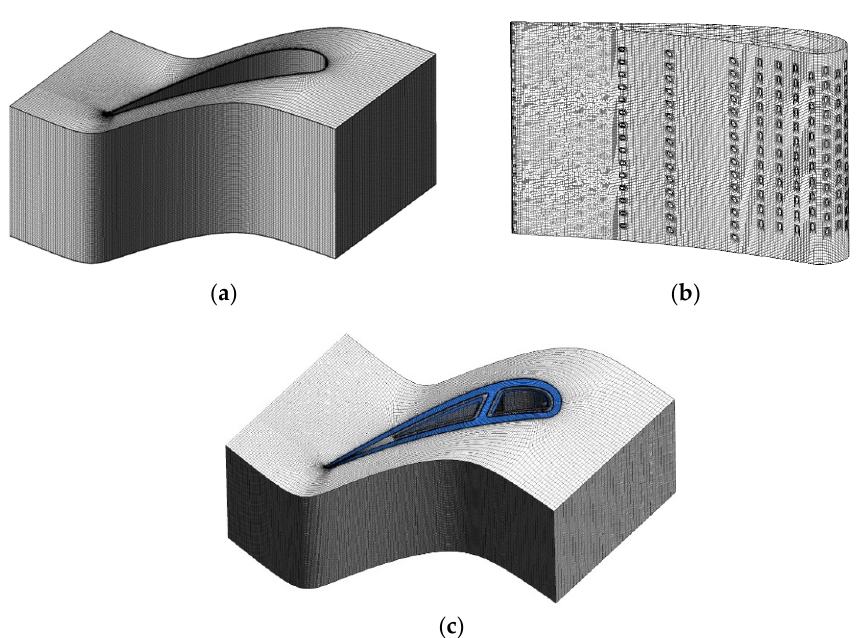
Figure 6. Mesh for data ‐ driven heat transfer analysis and validation: ( a ) Mesh 1; ( b ) Mesh 2; ( c ) Mesh 3.